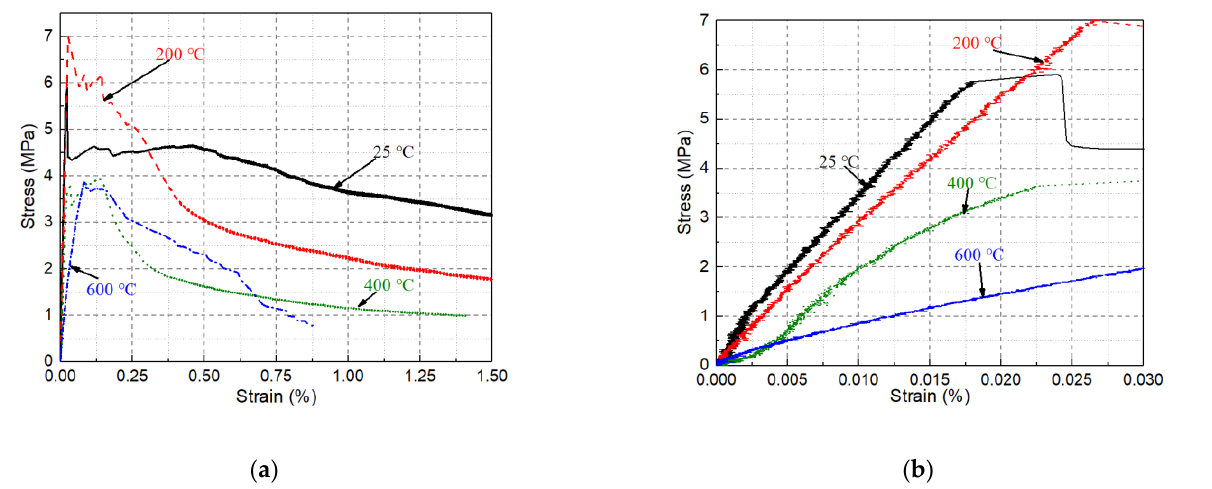
Figure 6. Uniaxial tensile stress-strain curve of heated MSFRC at ( a ) 0 – 1.5% and ( b ) 0 –